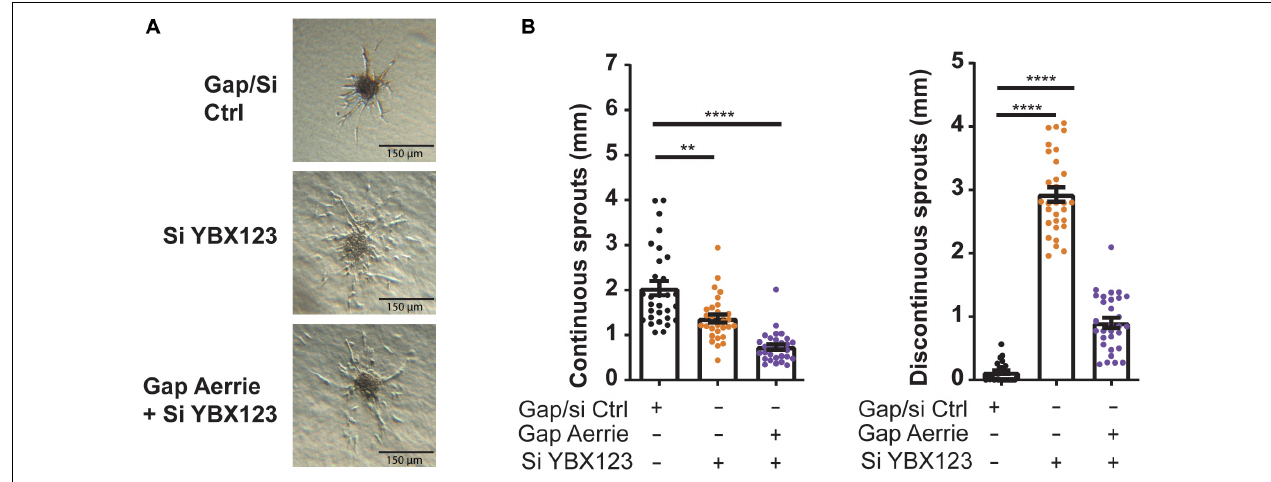
FIGURE 4 | Loss of Aerrie and YBX1/2/3 result in impaired sprouting. (A,B) HUVECs were treated with gapmeR (gap) targeting Aerrie, siRNA (si) targeting YBX1/2/3 or a respective control. (A) Sprouting assay (B) Quantification of the continuous and discontinuous sprouts per condition. ( n = 3, at least 10 spheroids per experiment). Sprouts measured by the distance from the tip cell to the stalk cell. ** p < 0.01; **** p < 0.0001; ns , not statistically